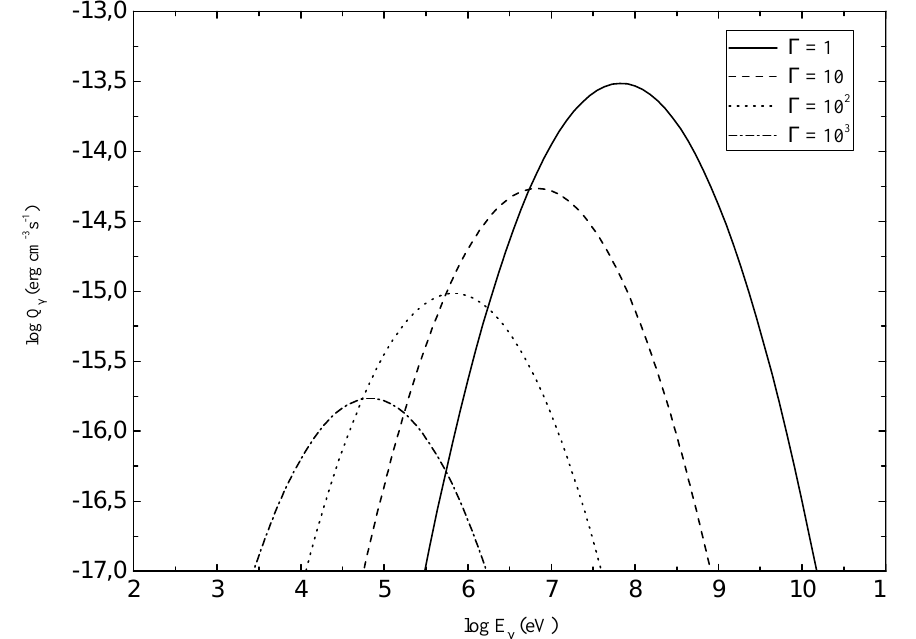
Figure 1. Gamma-ray production spectrum for ultrarelativistic plasma [28] taking into account the effects of the wormhole for different values of Γ